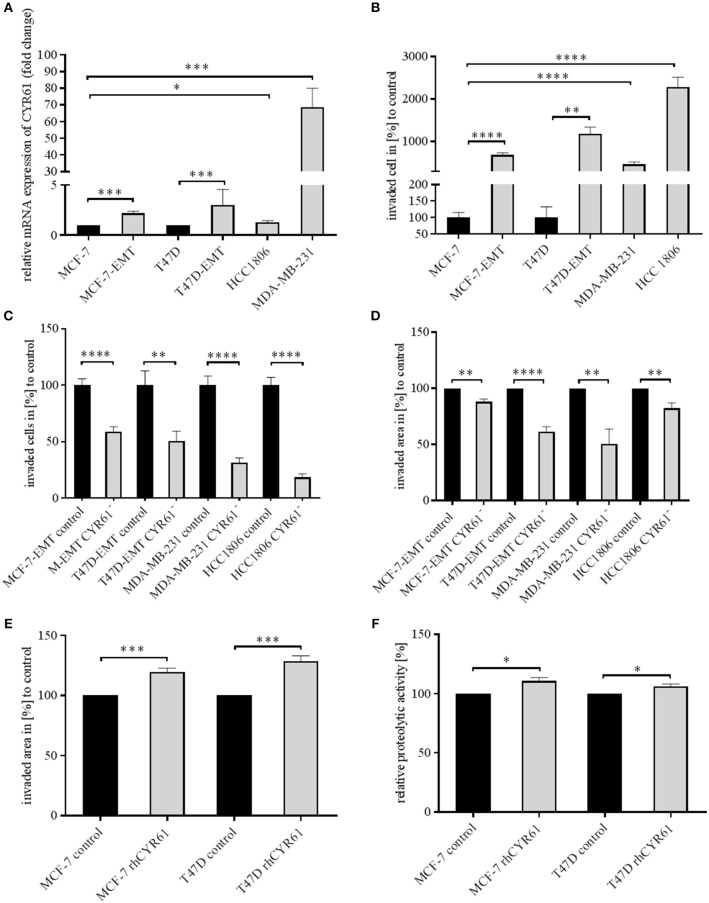
CYR61 expression correlates with breast cancer cell invasiveness. (A) Relative CYR61 expression of invasive breast cancer cell lines compared to non-invasive controls. Data represent mean ± SEM. Using unpaired, two-tailed t-test analysis. MCF-7-EMT n = 5; T47D-EMT n = 6; MDA-MB-231 n = 4; HCC1806 n = 3; *P < 0.05;
***P < 0.005 (B) 2D Invasion analysis of co-cultured (MG-63, osteosarcoma cells) breast cancer cells for 96 h. Percentage of cell invasion compared to controls was assessed by counting invaded cells under the filter in 4 random filter regions. Data represent mean ± SEM. Using unpaired, two-tailed t-test analysis. MCF-7-EMT n = 36; T47D-EMT n = 36; MDA-MB-231 n = 24; HCC1806 n = 54; **P < 0.01;
****P < 0.0001 (C) 2D Invasion analysis of co-cultured (MG-63, osteosarcoma cells) breast cancer cells transient transfected with CYR61 siRNA for 96 h. Percentage of cell invasion compared to controls was assessed by counting invaded cells under the filter in 4 random filter regions. Data represent mean ± SEM. MCF-7-EMT n = 36; T47D-EMT n = 18; MDA-MB-231 n = 18; HCC1806 n = 36; **P < 0.01;
****P < 0.0001 (D) 3D invasion analysis of breast cancer spheroids seeded after transient siRNA transfection. Spheroid area was assessed 48 h after adding Matrigel using polygonal selection and compared to spheroid area at time point 0 (adding of Matrigel). Area growth was compared to area growth of control spheroids. Data represent mean ± SEM. Using unpaired, two-tailed t-test analysis. MCF-7-EMT n = 5; T47D-EMT n = 6; MDA-MB-231 n = 5; HCC1806 n = 6; **P < 0.01;
***P < 0.005 (E) 3D invasion analysis of breast cancer spheroids treated with recombinant human CYR61 (rhCYR61). Spheroid area was assessed 48 h after adding Matrigel and rhCYR61 using polygonal selection and compared to spheroid area at time point 0 (adding of Matrigel+ rhCYR61). Area growth was compared to area growth of control spheroids. Data represent mean ± SEM. Using unpaired, two-tailed t-test analysis. MCF-7 n = 3; T47D n = 3; ***
P < 0.005 (F) Proteolytic activity of non-invasive breast cancer cells treated with rhCYR61 was asses by measurement of fluorescence 24 h after seeding cells on wells coated with FITC-labeled gelatin. Relative proteolytic activity of rhCYR61 treated cells was compared to proteolytic activity of control cells. Data represent mean ± SEM. Using unpaired, two-tailed t-test analysis. MCF-7 n = 3; T47D n = 3 *P < 0.05.